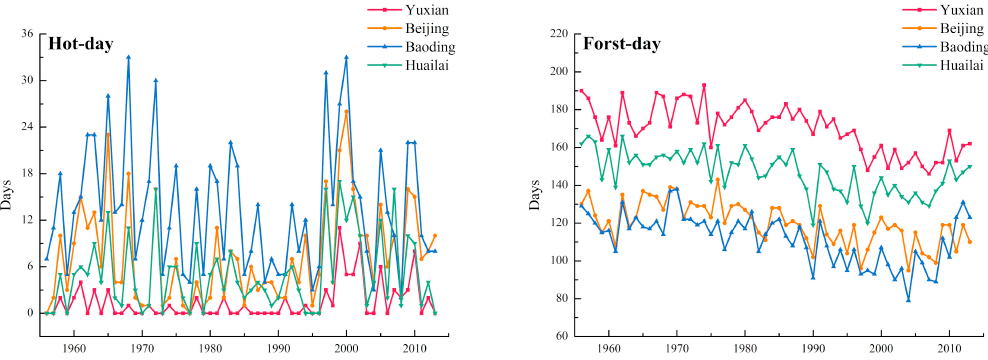
Figure A2. Time series of Hot-day (Temperature ≥ 30 °C) and Frost-day (Temperature ≤ 0 °C).